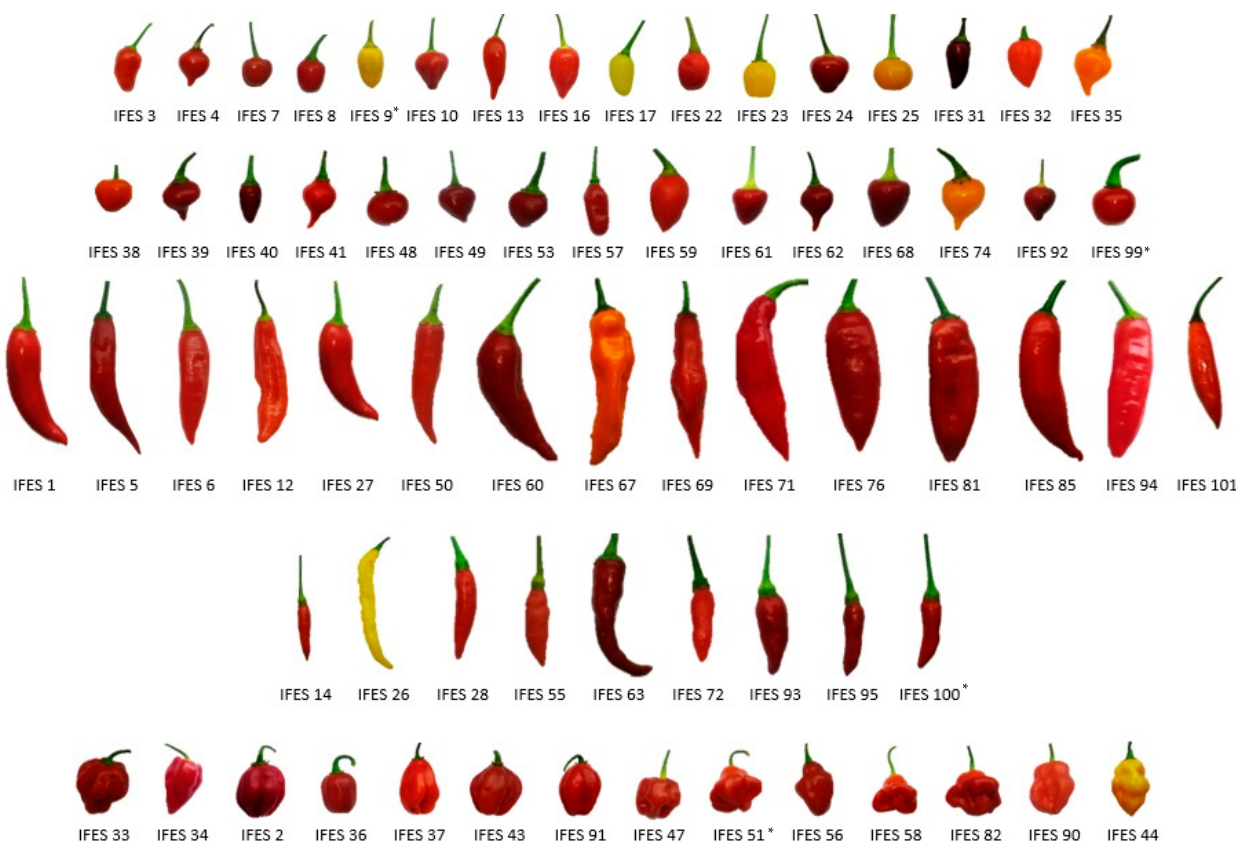
Figure 1. Phenotypic representation of fruits of 69 Brazilian Capsicum spp. accessions studied. *—commercial varieties.